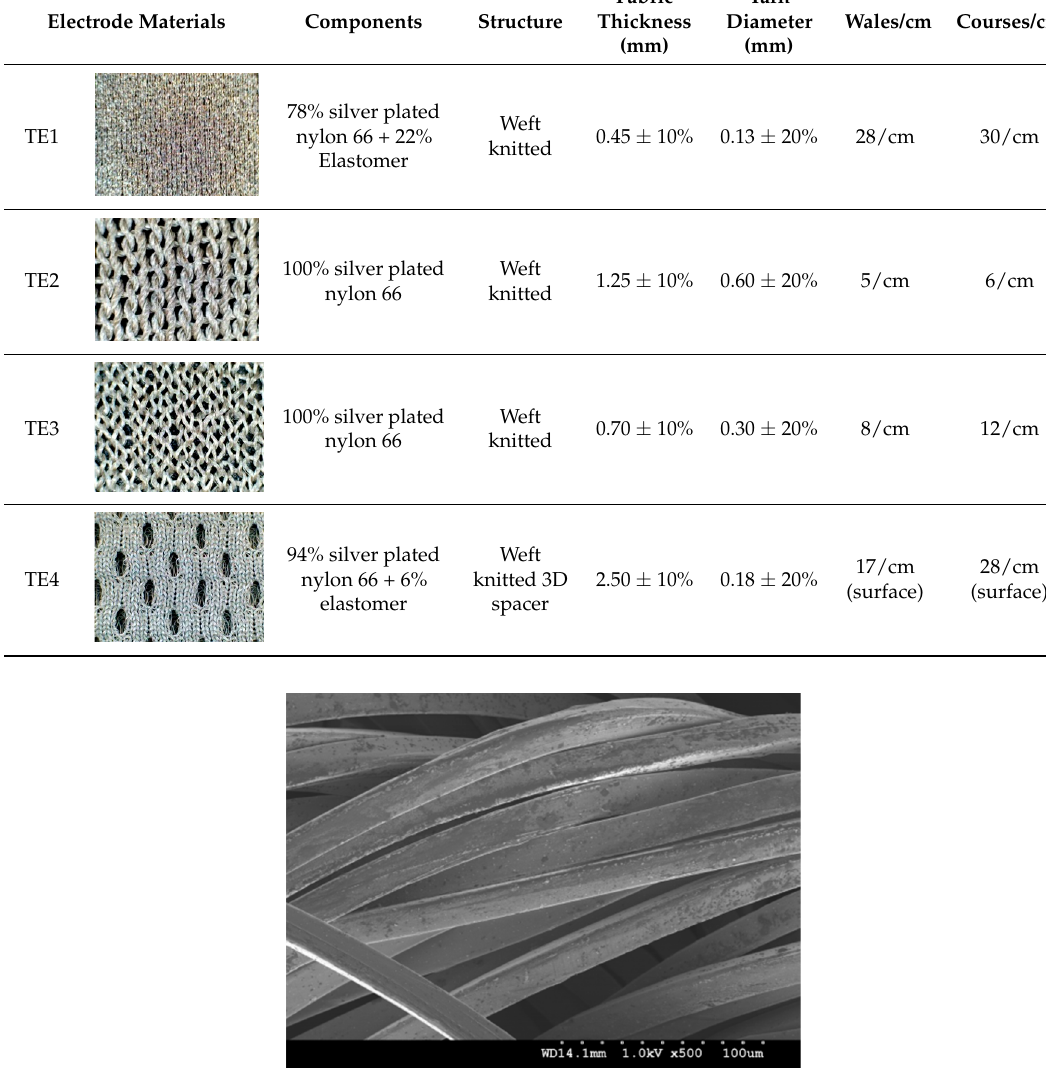
Figure 2. The scanning electron microscope (SEM) micrograph of a silver plated nylon yarn. Table 1. The properties of the four selected conductive knitted fabrics.